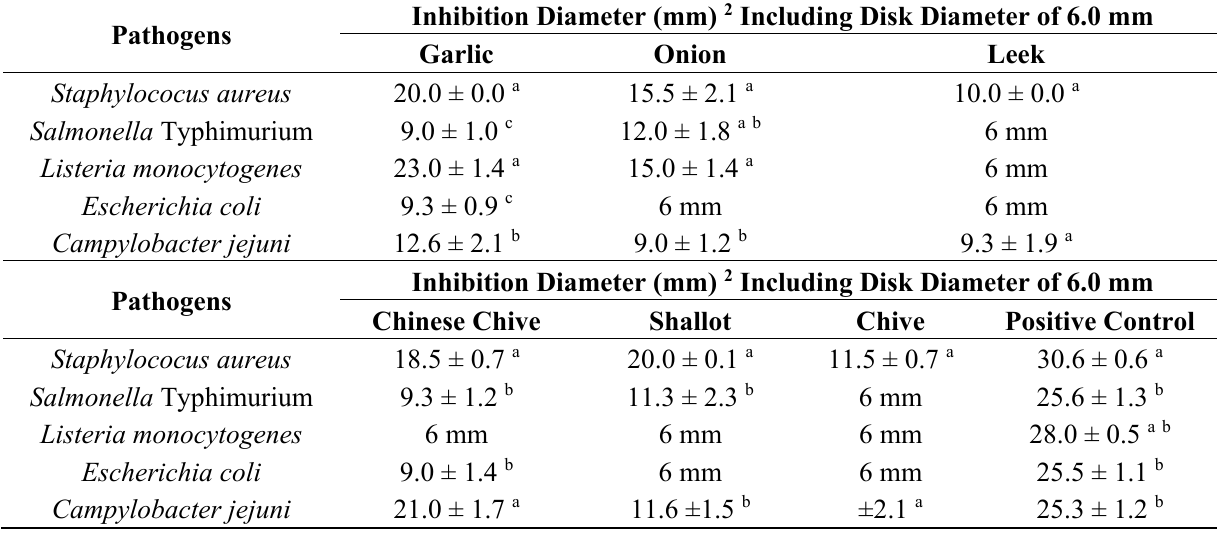
Table 2. Antibacterial activity of garlic, onion, leek, Chinese chive, shallot, chive EO and positive control after 48 h 1